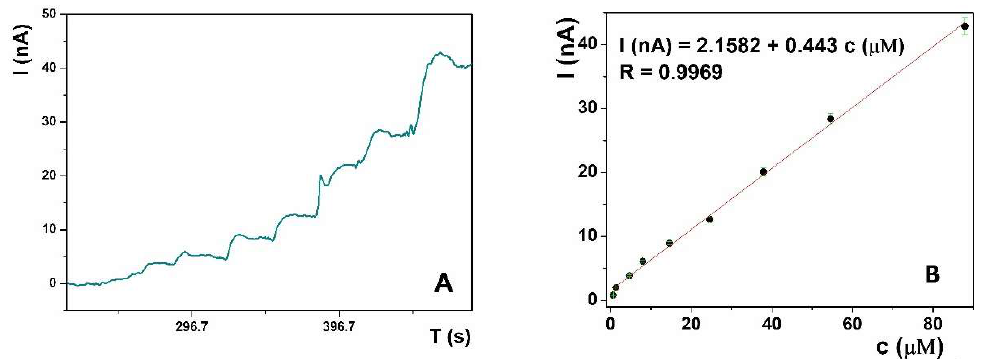
Figure 3. ( A ) Amperometric response of the La(OH) 3 @MWCNT modified CP electrode in 0.1 M PB pH 6 towards successive addition of UA standard solution. ( B ) Calibration curve of amperometric current depending on the concentration of UA in the analyte solution, in the range from 0.67 μM to 121 μM.